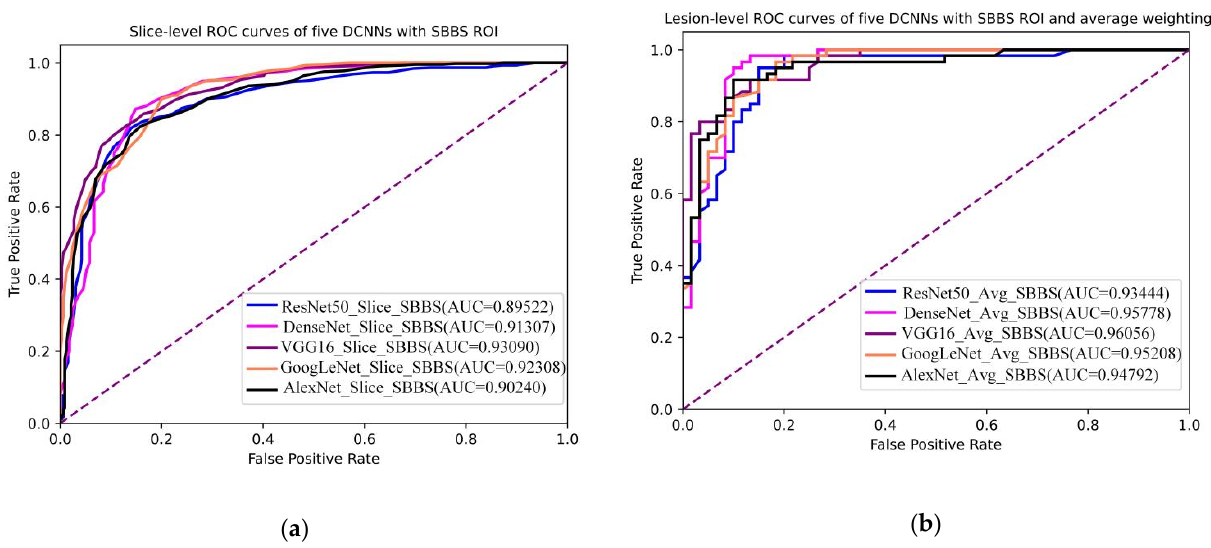
Figure 6. ROC curves and AUC values of five DCNNs slice-level classification and lesion-level diagnosis. ( a ) Slice-based classification. ( b ) Lesion-level